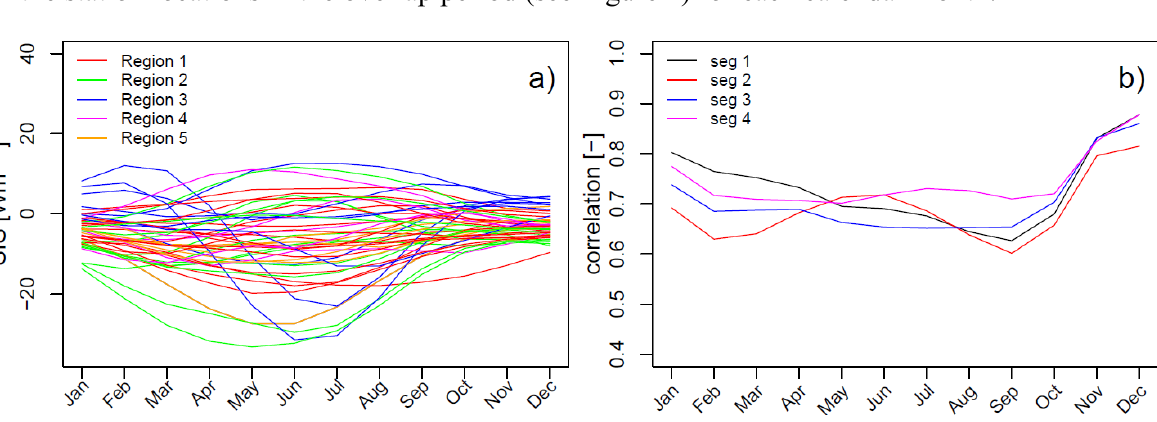
Figure 9. ( a ) Smoothed annual cycles of the mean-shifts for the change from Meteosat 7 to Meteosat 8 obtained using the 47 difference series (CM SAF minus GEBA), and ( b ) correlation coefficients between the station-wise derived mean-shifts (each color indicates a segment) and the difference in SIS derived from Meteosat 7 and Meteosat 8 at the station locations in the overlap period (see Figure 2) for each calendar